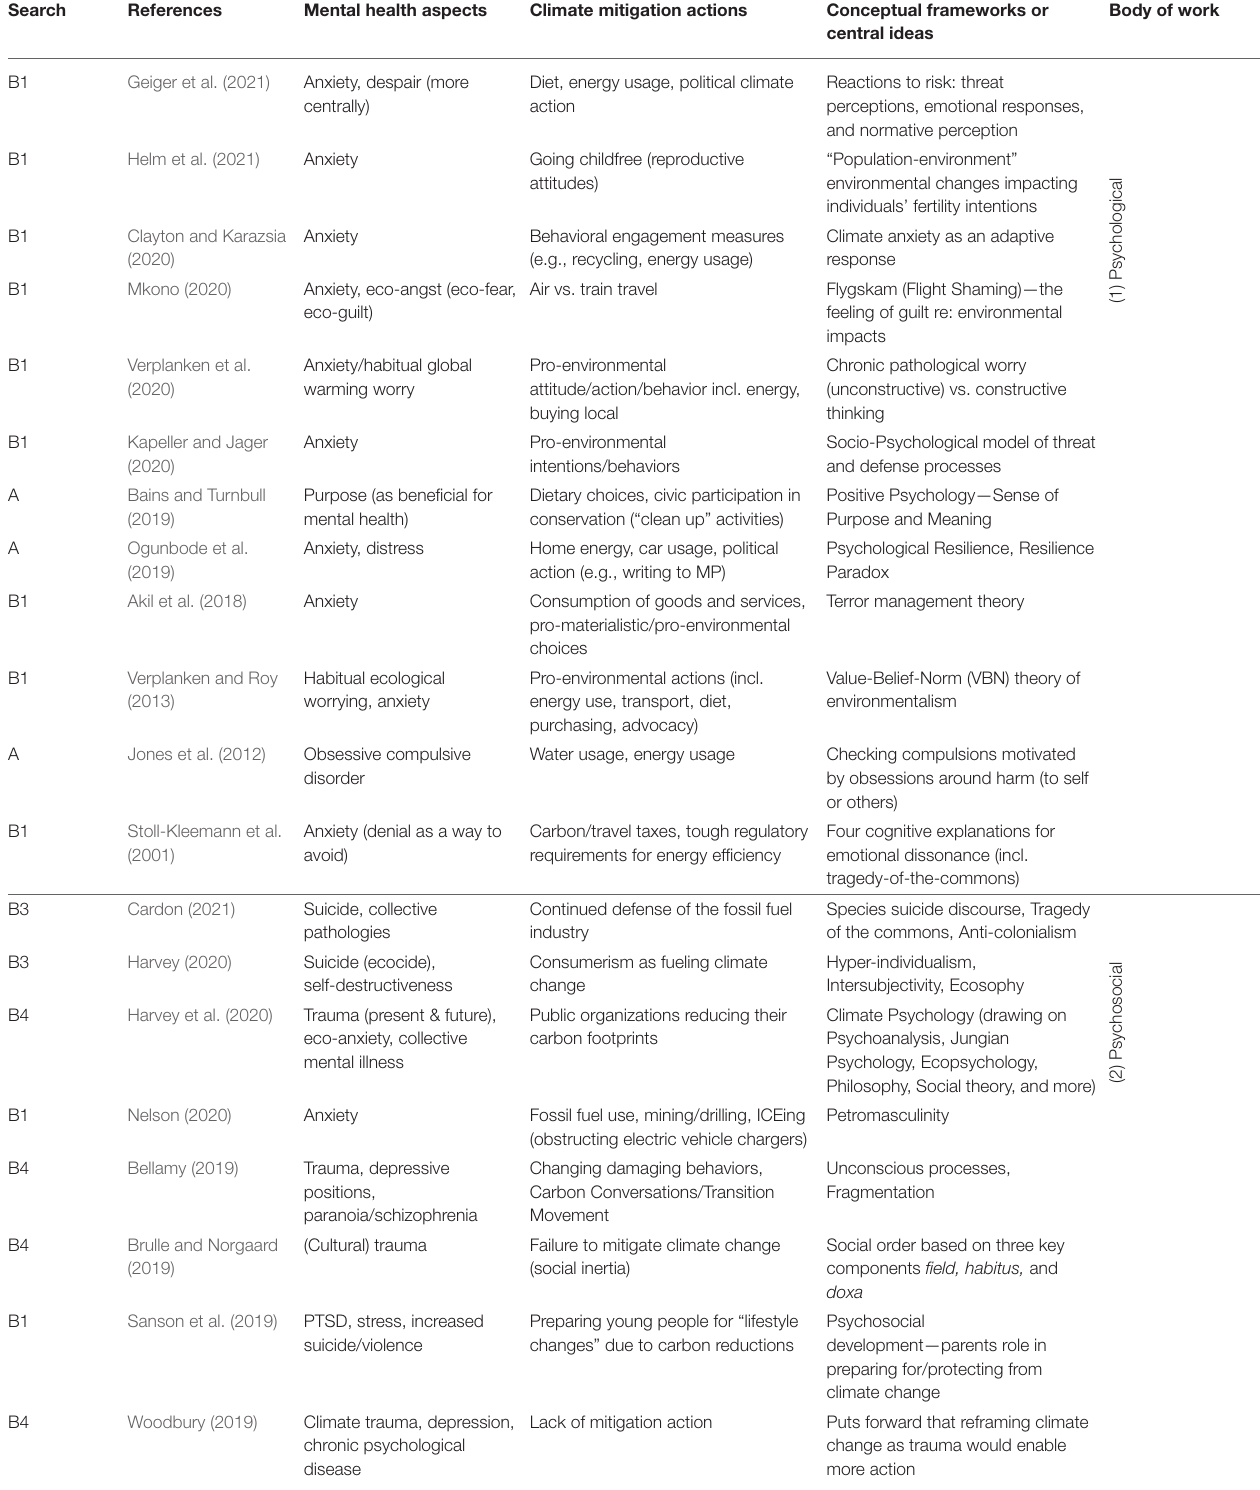
TABLE 4 | Papers included in our in-depth review highlighted links between mental health issues and climate mitigation action.